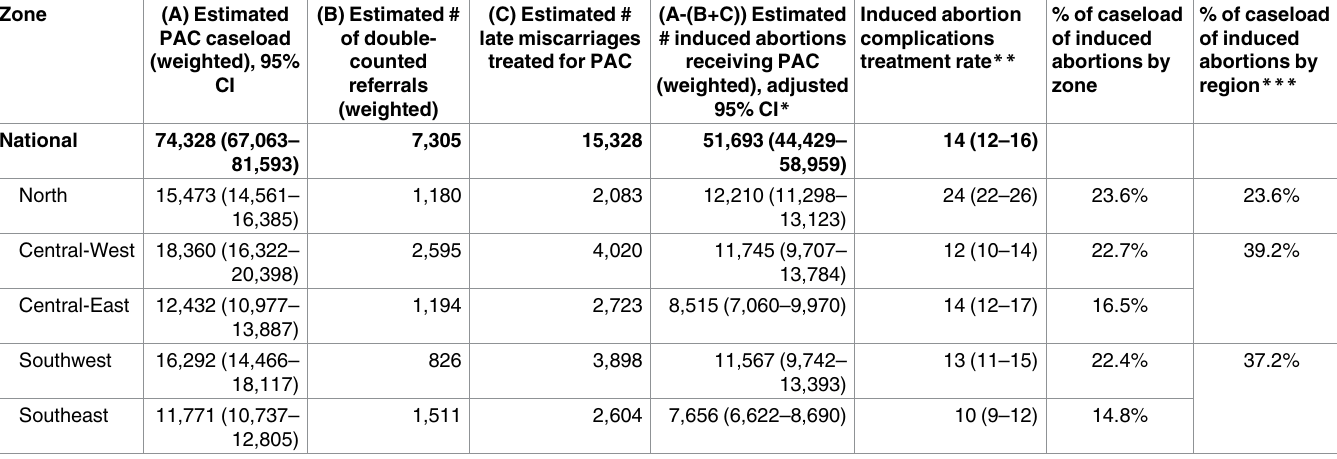
Table 3. Post-Abortion Care (PAC) cases in Malawi, Health Facilities Survey, Malawi